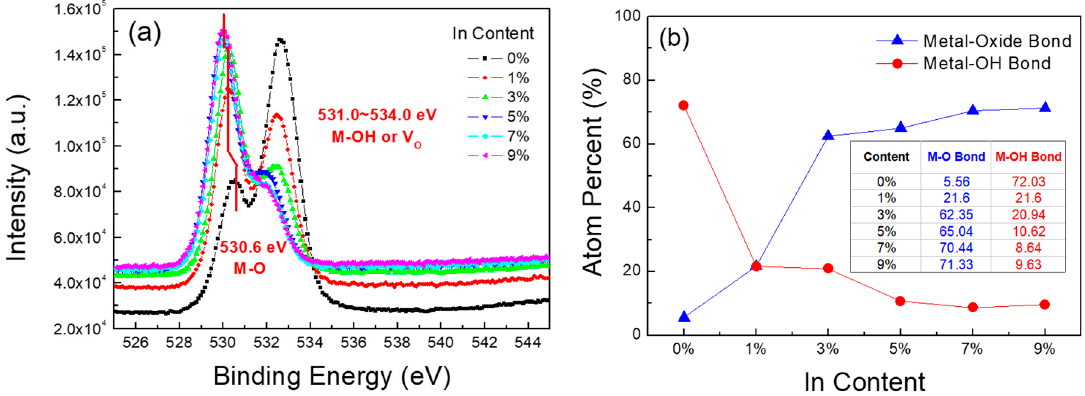
Figure 3. ( a ) O 1s XPS spectra of the In-doped ZnO films with different In concentrations; ( b ) Atom percent of metal-oxide bonds and metal-OH bonds in In-doped ZnO thin films.